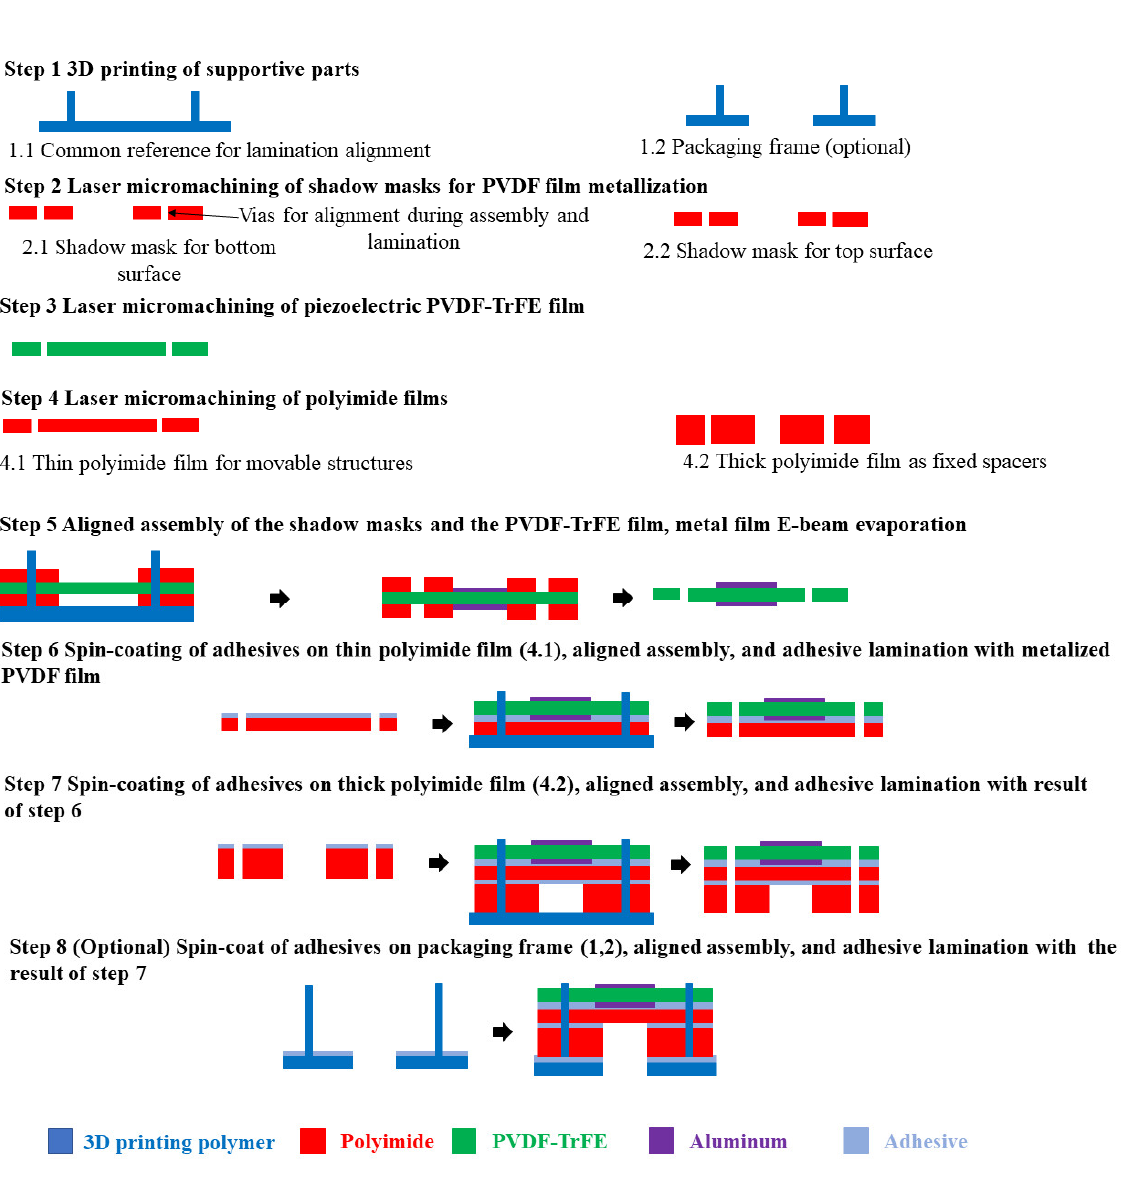
Figure 1. A microfabrication flow of polymeric piezoelectric MEMS devices based on laser micromachining, 3D printing, and adhesive lamination.